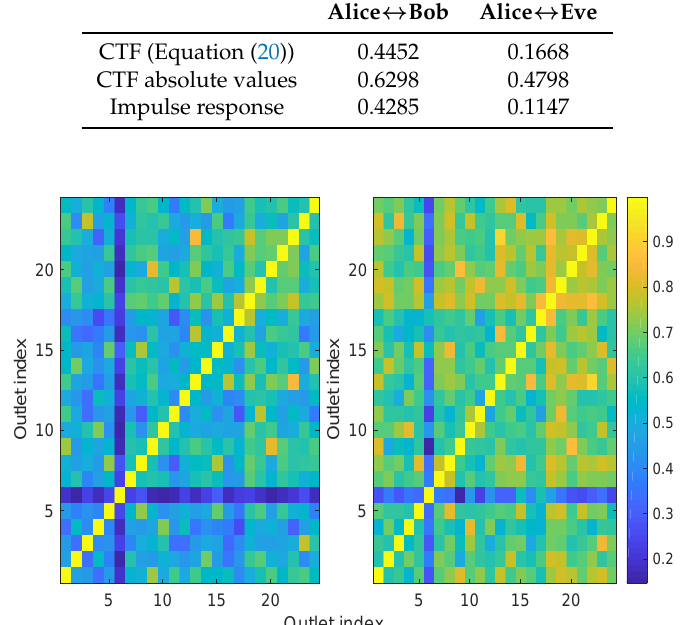
Figure 8. Correlation coefficients | ρ Z | ( left ) and ρ Z same